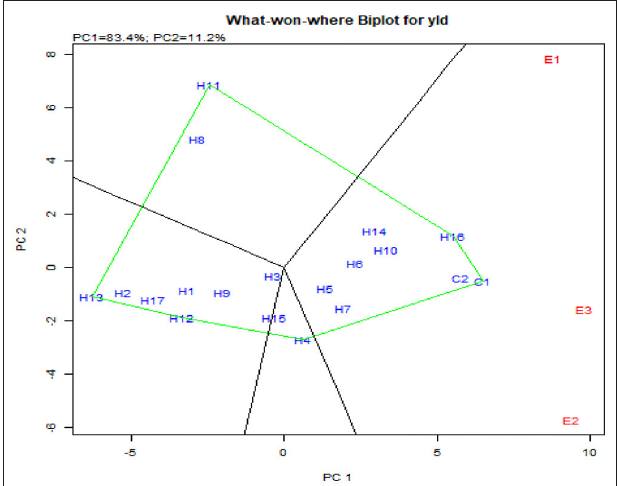
Frontiers in Plant Science |